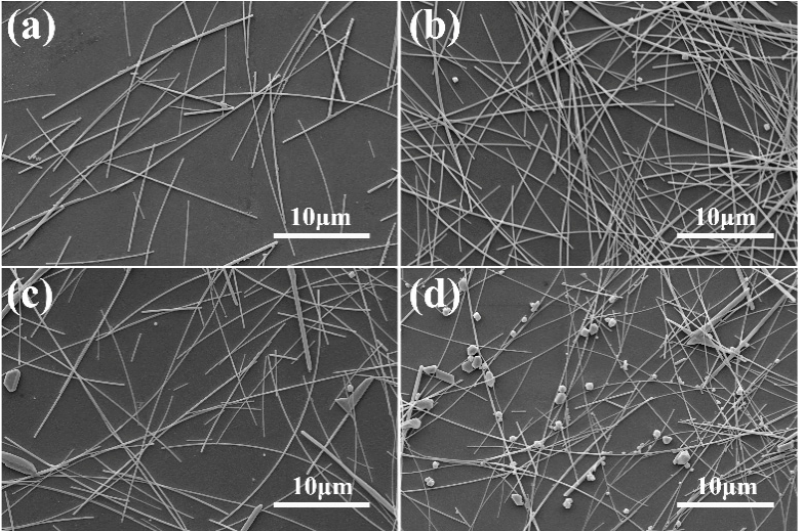
Figure 2. SEM of Ag NWs with diameters of ( a ) 88 nm, ( b ) 70 nm, ( c ) 60 nm, and ( d ) 47 nm.